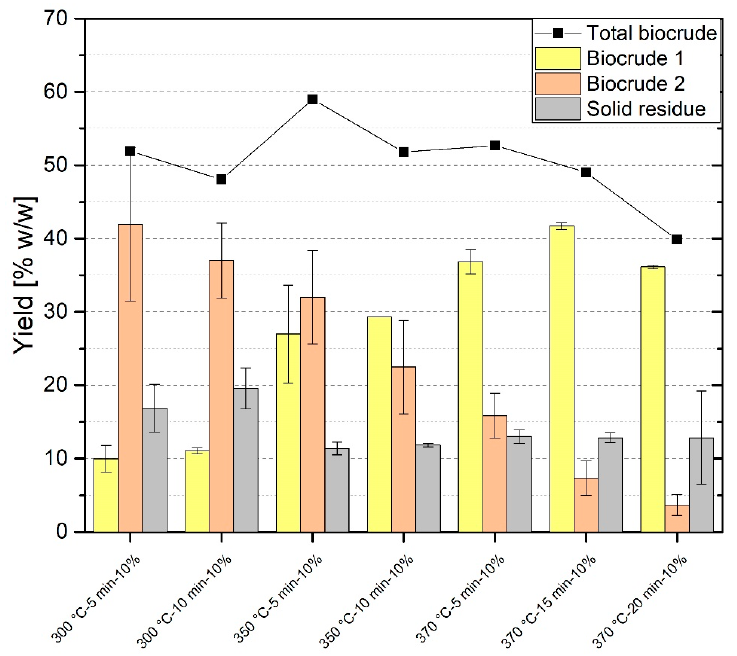
Figure 8. Effect of increased temperature and reaction time on products yield; error bars represent absolute standard deviation.